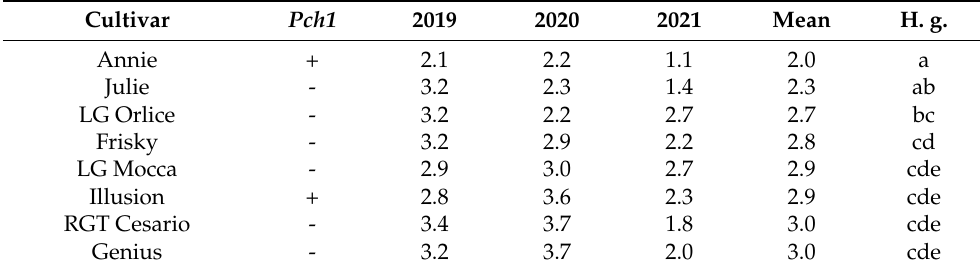
Table 2. Evaluation of eyespot symptoms on winter wheat cultivars after Oculimacula spp. inoculation in three-year trials in Prague-Ruzynˇe